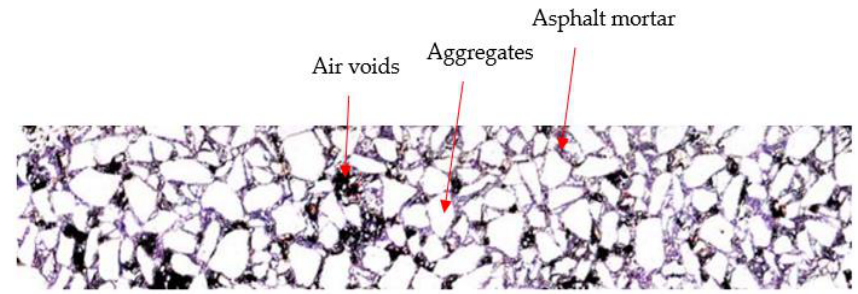
Figure 4. Adjusted Digital Image.